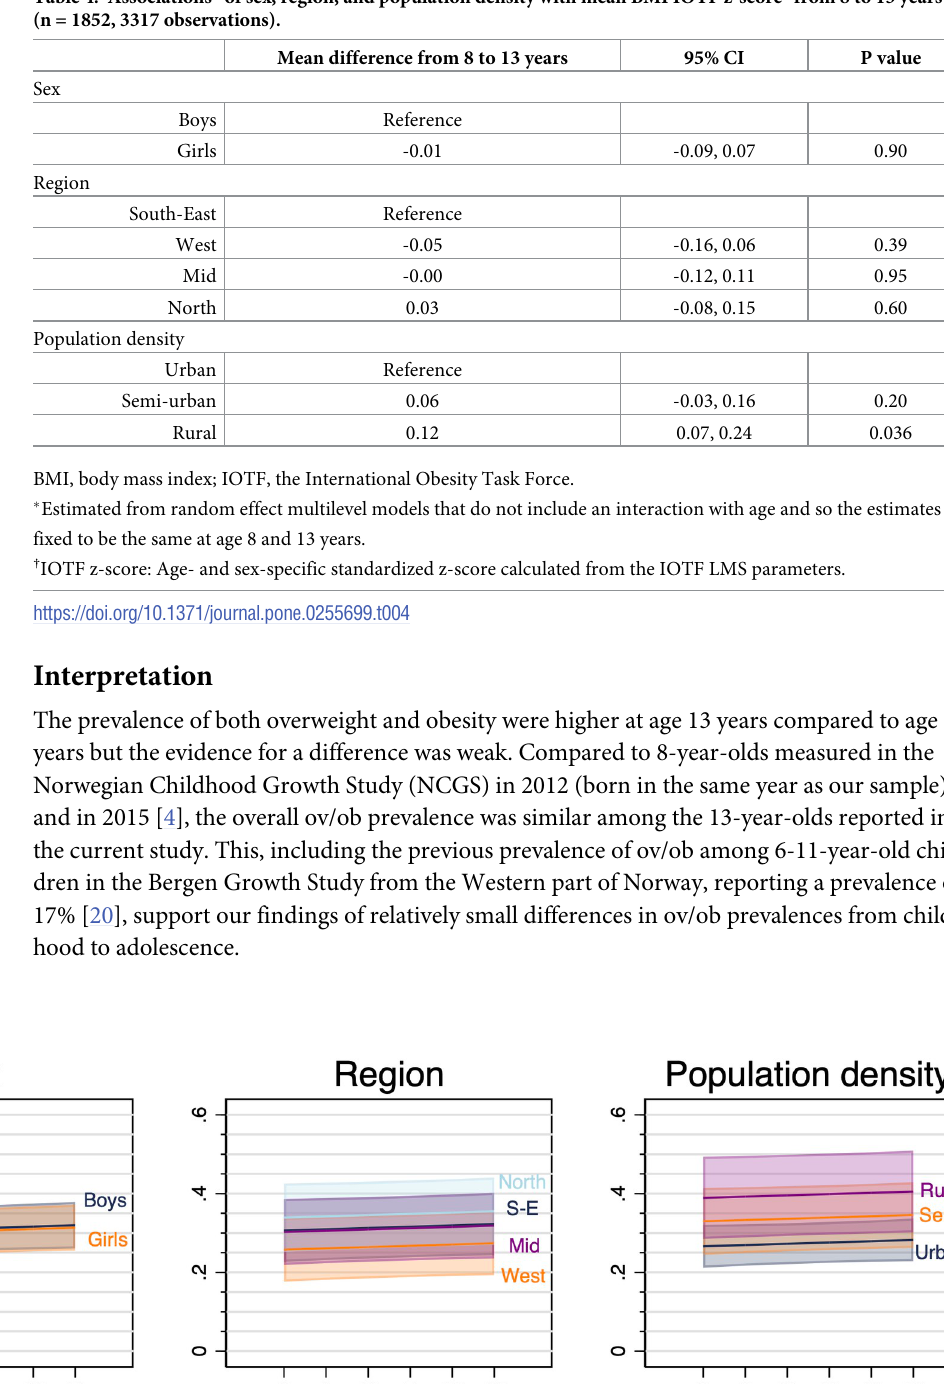
PLOS ONE | https://doi.org/10.1371/journal.pone.0255699 August 3,